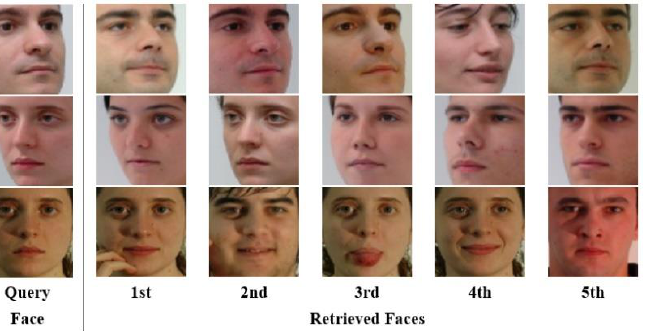
Figure 7. Face retrieval result. Faces were sorted in ascending order by pose vector distance (i.e., the smallest Euclidean distance value is ranked as 1st).